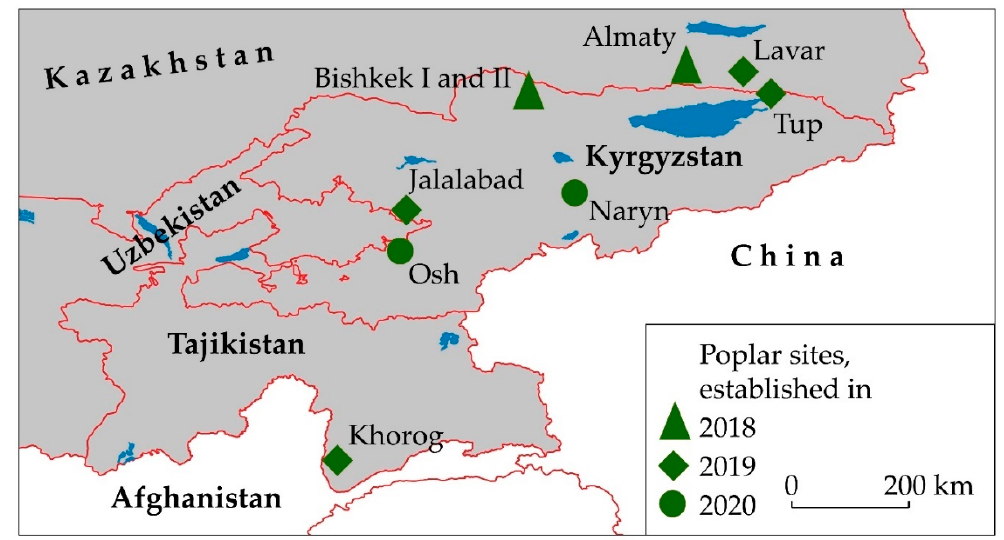
Figure 1. Location of the poplar testing sites. Table 3. Climate features at the sites (www.weatherbase.com).